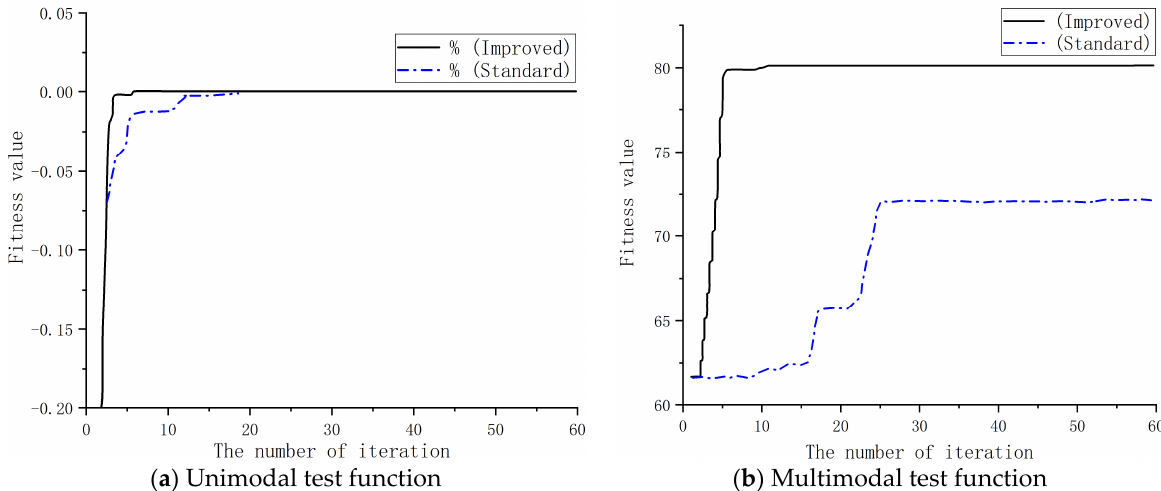
Figure 15. Comparison of convergence processes. Table 1. Comparison of PSO optimization results before and after improvement.